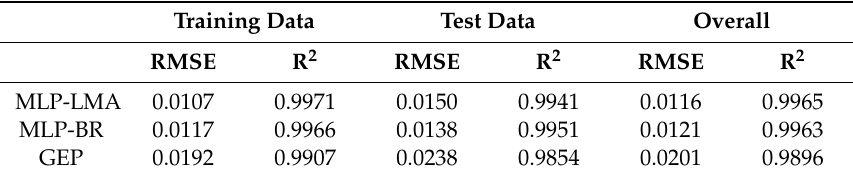
Table 3. Statistical parameters of the proposed models in predicting CO 2